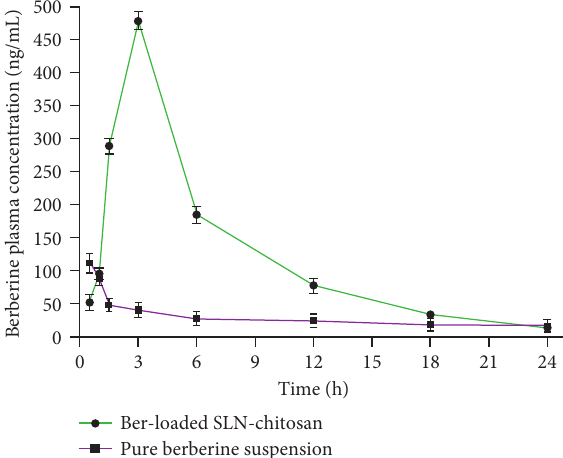
Figure 3: The profiles of the plasma concentration of berberine versus time after oral administration of Ber-loaded SLN-chitosan nanoparticles and the pure suspension of berberine in rats. Data are expressed as the mean ± SD ( n � 10). Table 2: Pharmacokinetic parameters in the treated rats after a single oral dose administration of Ber-loaded SLN-chitosan nanoparticles and pure suspension of berberine.